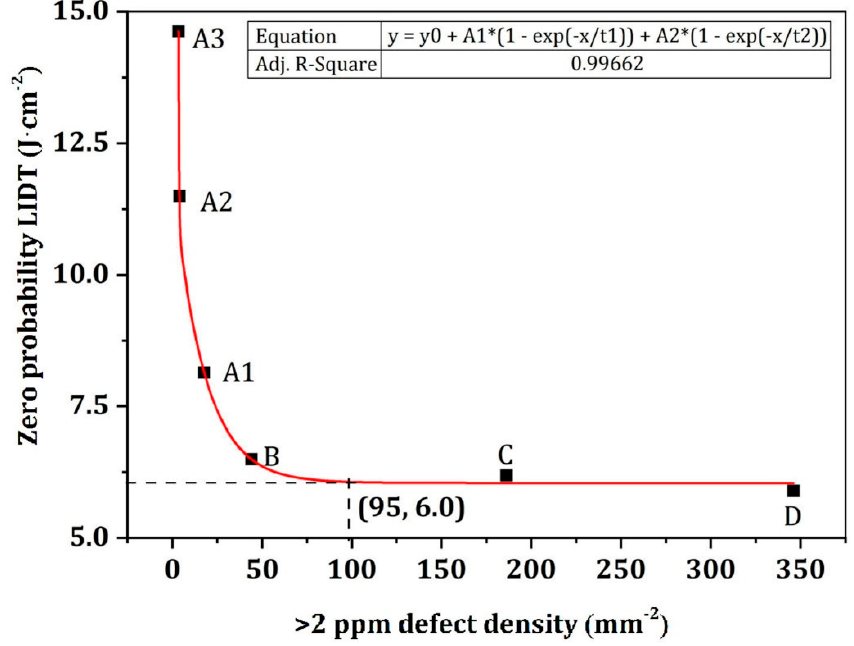
Figure 7. Fitting relationship between defect density with absorption over 2 ppm and zero probability damage thresholds.